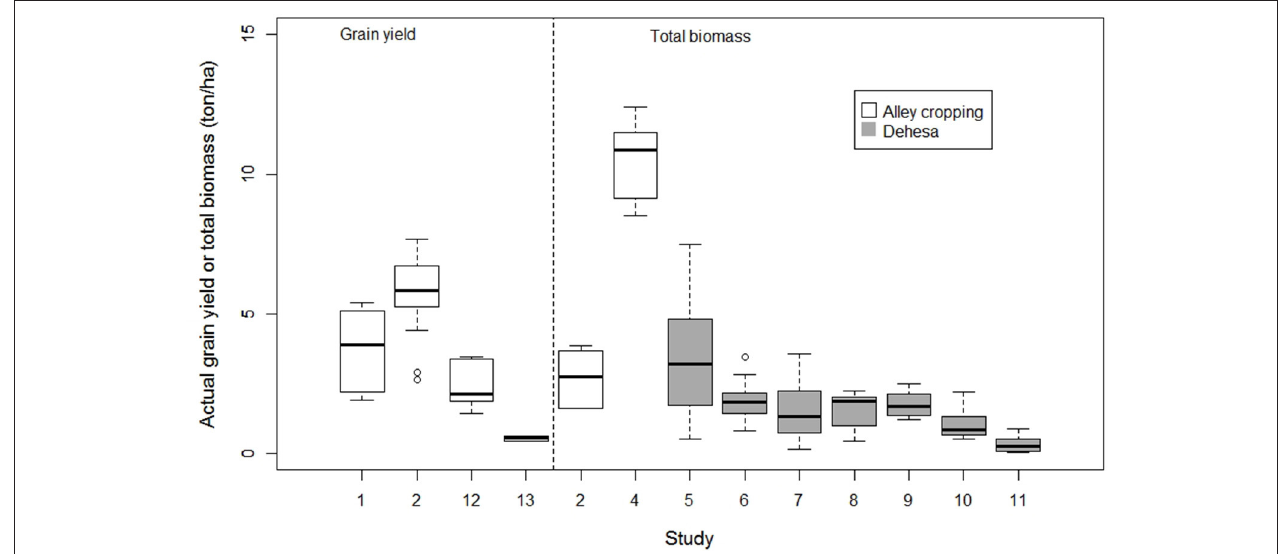
FIGURE 3 | Boxplot of grain yield (studies 1 and 2) and total biomass (studies 2 and 4–10) in agroforestry systems in Europe. The lower and upper borders of the boxes represent the first and the third quartile of measured yield in the study. The middle bar represents the median. The upper whisker represents the third quartile plus 1.5 times the interquartile range (IQR) or the largest value observed in the study, whichever of the two is closer to the median. The lower whiskers represents the first quartile minus 1.5 times the IQR or the lowest crop yield in a study whichever of the two is closer to the median. Data more extreme than the whiskers are drawn as individual points. Study 3 is not represented in this figure because only relative yield data were available.